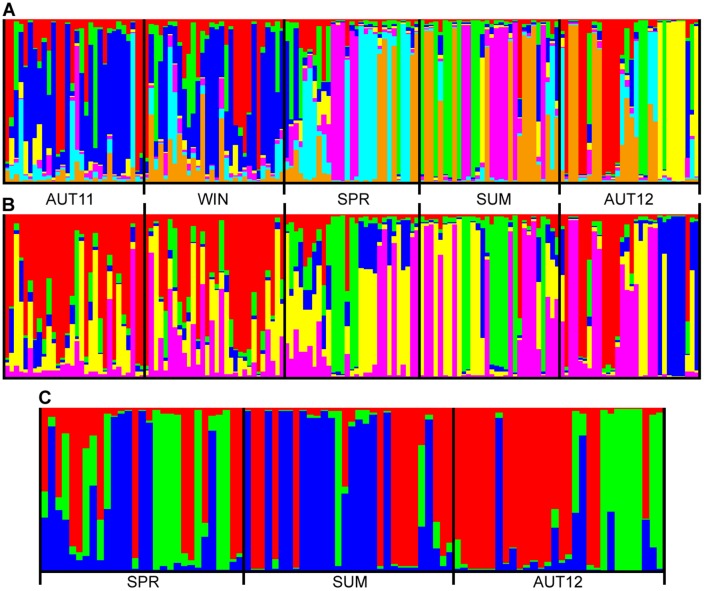
Graphical presentation of the Bayesian model-based clustering analysis.Each individual is represented by a vertical bar. (A) k = 7, the best value of K for all mosquitoes of the chronological samples. (B) k = 5, arbitrarily chosen to match the number of chronological samples. (C) k = 3, the best value of K for all mosquitoes from trap T6.